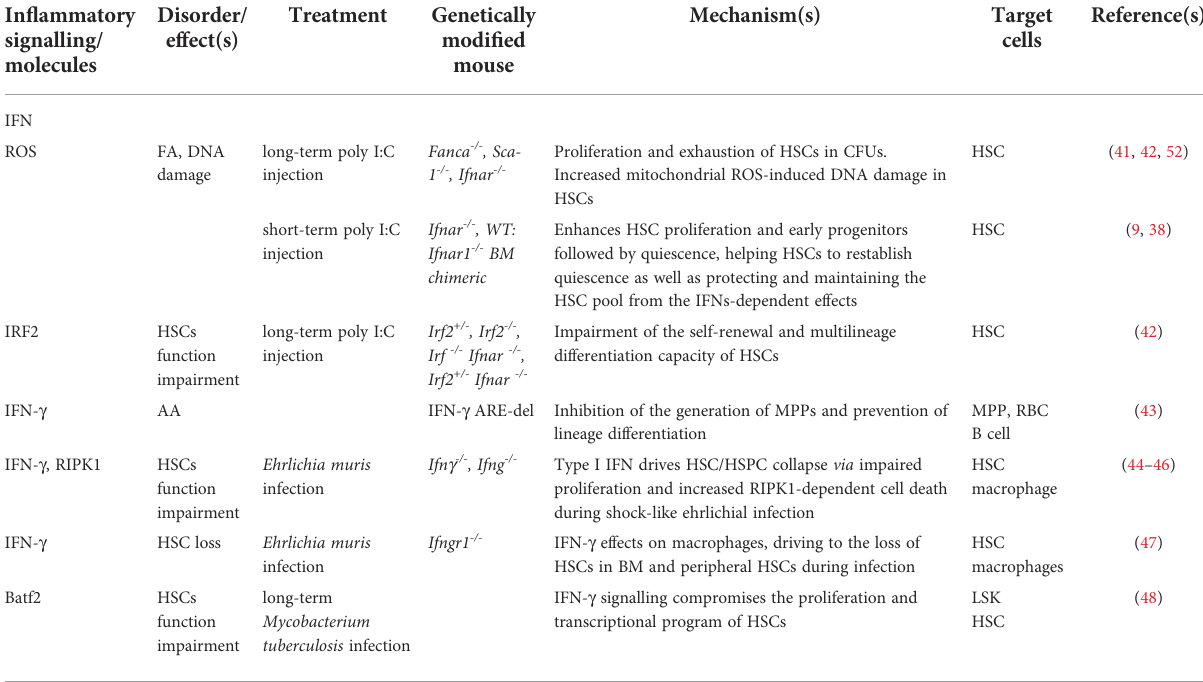
TABLE 1 In fl ammatory signalling in the mouse models with implication in the bone marrow